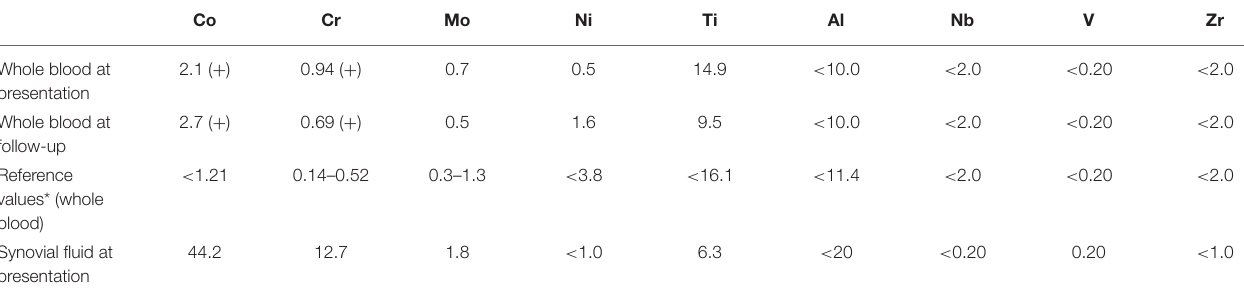
TABLE 1 | Systemic and local metal levels [ µ g/l] analyzed with inductively coupled plasma mass